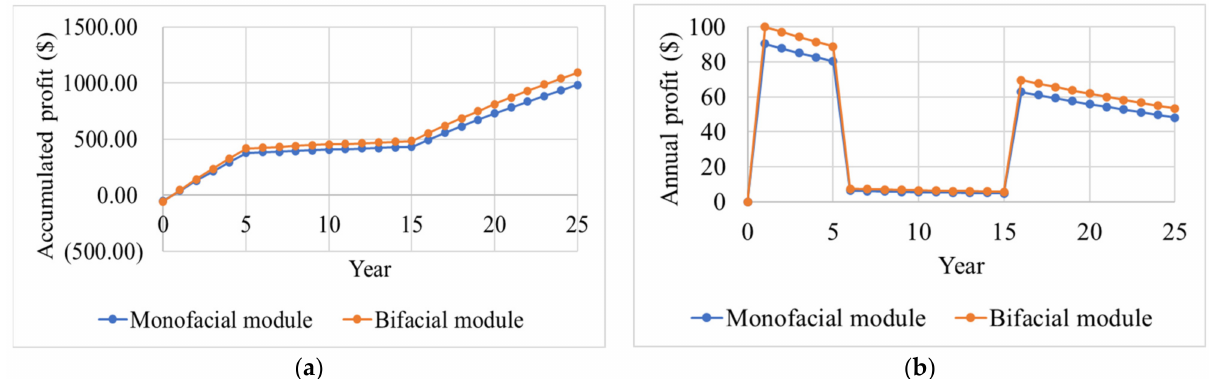
Figure 3. Profits from the two types of solar modules with a loan at a rate of 1.75%: ( a ) Accumulated profit; ( b ) Annual (non-accumulated)